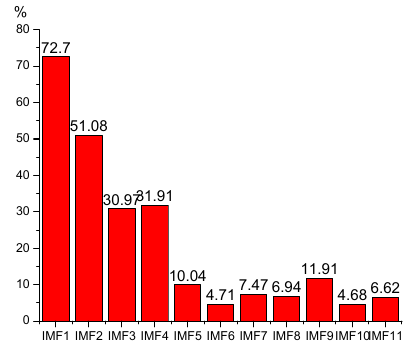
Figure 11. Cross correlation for the IMF components and the original signal.